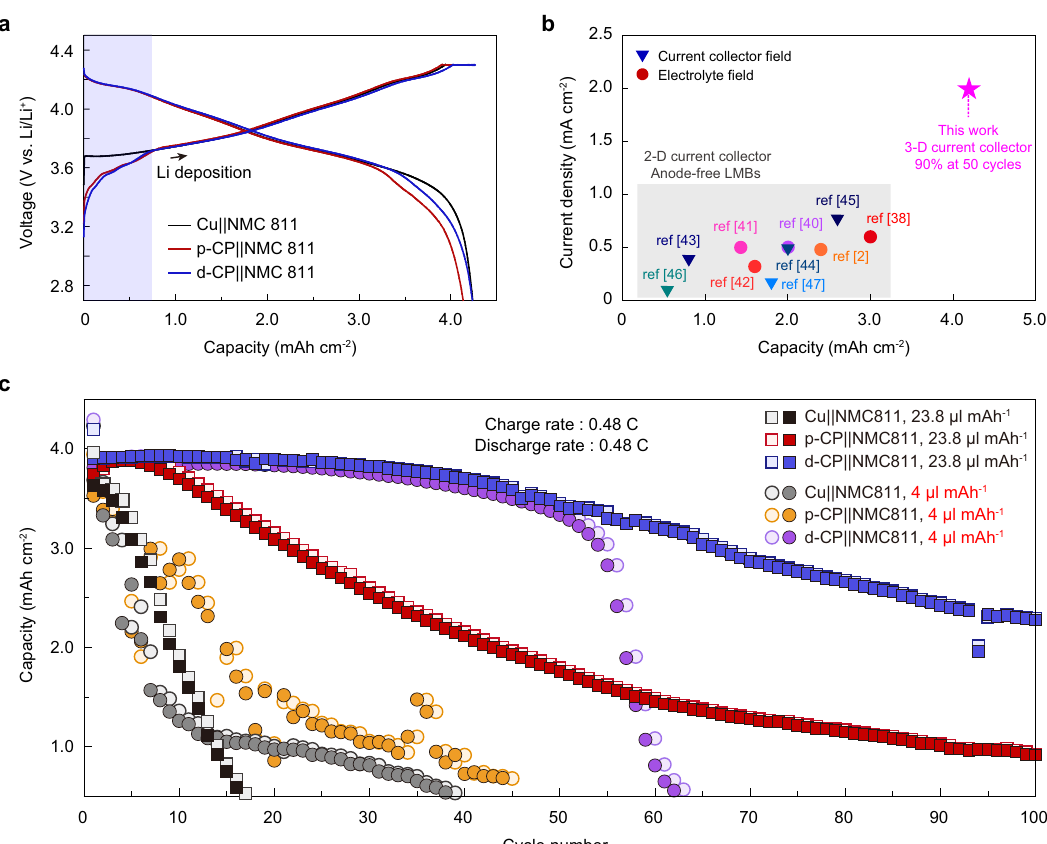
Fig. 7 Electrochemical performance of anode-free coin cells with d-CP under practical conditions. a Voltage pro fi les of the anode-free NCM811 full cell with Cu, p-CP, or d-CP during the charge at 0.1 C, sequential constant voltage charging at 4.3 V (cutoff current: 0.02 C), and discharge. b Comparison of the areal capacity and current density that ensures stable operation in this work and previous works. c Plots of charge and discharge capacity as a function of cycle number for anode-free NCM811 full cells with 1 M LiPF 6 EC/DEC + 10% FEC + 1% VC under fl ooded cell conditions (E/C ratio of 23.8 μ l mAh − 1 , square symbols) and lean electrolyte conditions (E/C ratio of 4.0 μ l mAh − 1 , circle symbols). The fl ooded and lean electrolyte cells were cycled at a